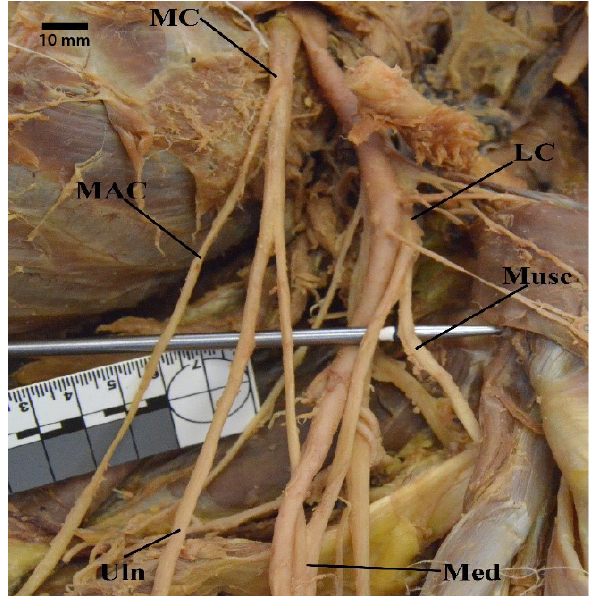
Figure 7. Photograph of an individual in which a long medial cord gives rise very proximally to medial antebrachial cutaneous nerve. Abbreviations: LC = lateral cord; MAC = medial antebrachial cutaneous nerve; MC = medial cord; Med = median nerve; Musc = musculocutaneous nerve; Uln = ulnar nerve.